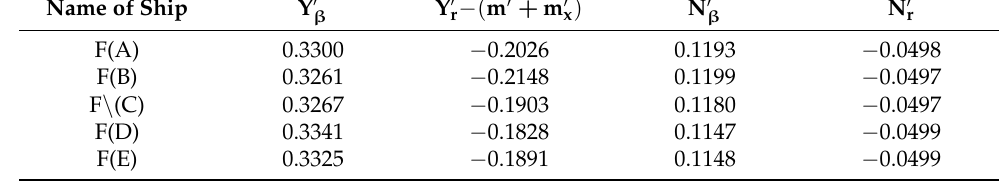
Table 3. Linear coefficients of the model fishing vessels derived from the corrected empirical formula.